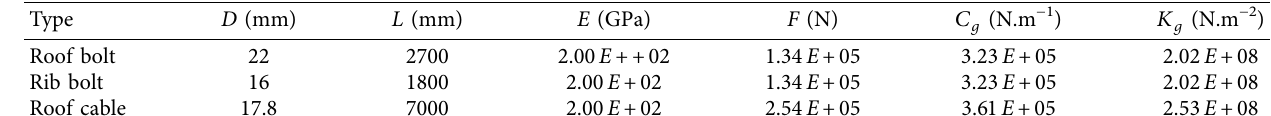
Figure 19: Stress distribution curve of different layers of floor. Table 4: Bolt/cable properties used in the numerical model.